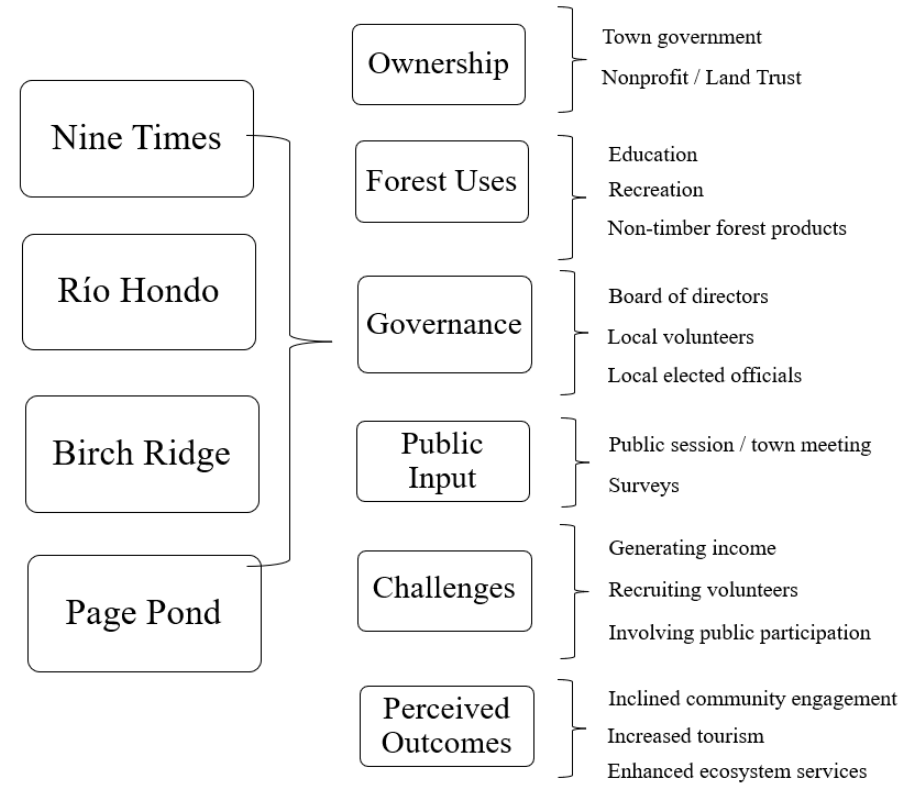
Figure 1. Qualitative data coding tree.